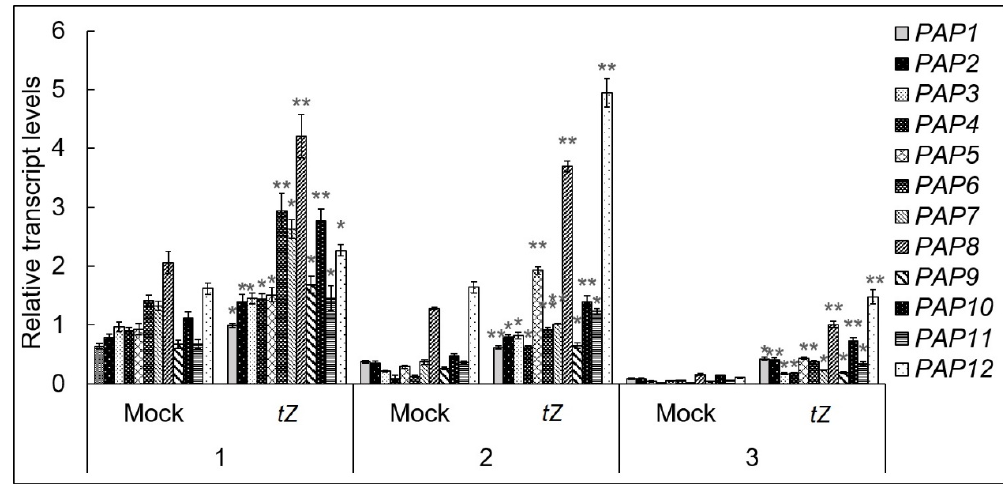
Figure 1. Age-related changes in the accumulation of PAP gene transcripts after trans-zeatin (5 µM, 3 h) treatment. A. thaliana Col-0 plants were grown on MS medium in Petri dishes for one week or in soil under a 16 h light/8 h dark photoperiod at 23 °C with 100 µE m − 2 s − 1 . Total RNAs were isolated from 7-day-old seedlings (1) or the 6th leaf of 3-(2) and 7-(3) week-old A. thaliana plants. RNAs were analyzed by relative quantitative RT-PCR using UBQ10 and PP2A as internal standards. Data represent the means and SEs values of three independent biological replicates. Asterisks indicate significant differences from the value of respective mock control samples (* p < 0.05; ** p < 0.01).